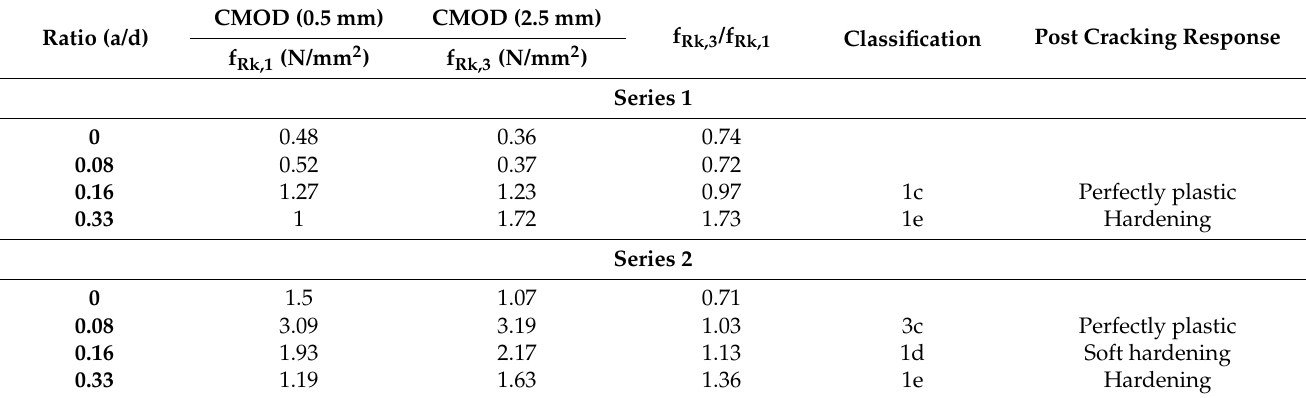
Table 4. Classification of the residual stress for Series 1 and 2.